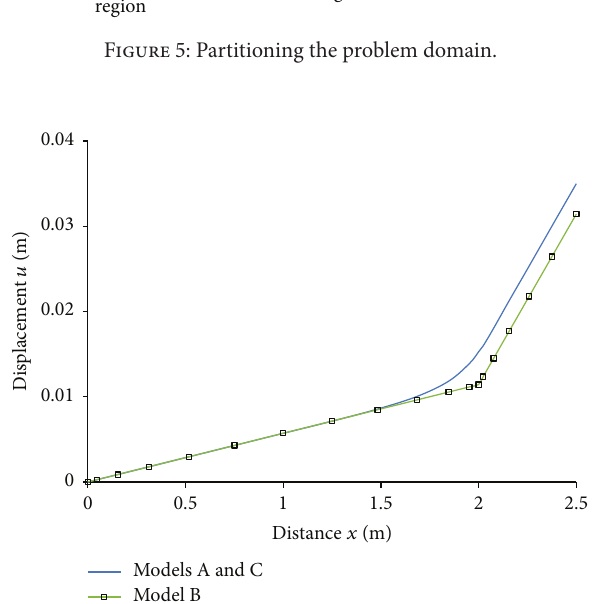
Figure 6: Variation of axial displacement near step.